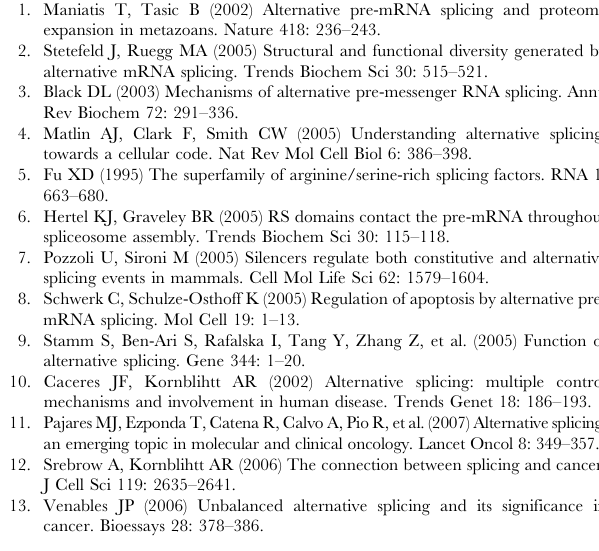
Figure S2 Inhibitory effects of amiloride treatment on CD133 expression and clonogenicity of Huh-7 cells. (TIF) Figure S3 Cytotoxic and growth inhibitory effects of amiloride on various human cancer leukemia and normal cells in vitro. (TIF) Figure S4 Characterization of common genes subject to amiloride modulation of RNA alternative splicing in three human neoplastic cell lines. (TIF) Table S1 Top scoring candidate gene transcripts show- ing amiloride-altered alternative splicing in Huh-7 cells. The raw data have been deposited in a MIAME compliant database